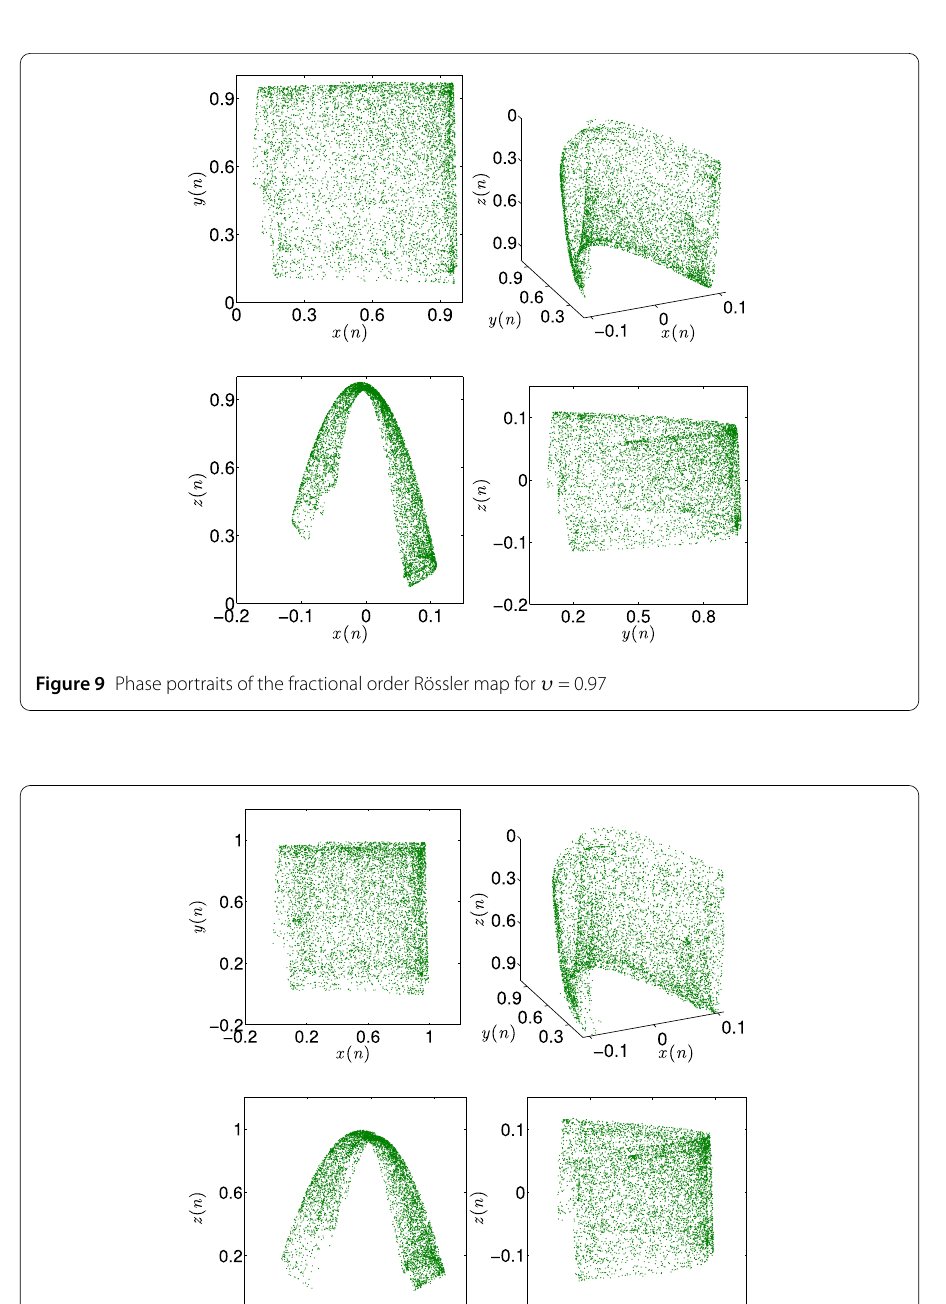
0.903. Figure 11 shows the bifurcation diagram for υ = 0.97 with b 1 as the critical pa- rameter and ( b 2 , b 3 , b 4 , b 5 , b 6 , b 7 ) = (0.05,0.35,3.78,0.2,0.1,1.9). The critical parameter was varied with the step size (cid:2) b 1 = 0.001. Figure 12 shows the bifurcation diagram of the fractional Rössler map with υ ∈ [0.9,1] as the critical parameter, ( b 2 , b 3 , b 4 , b 5 , b 6 , b 7 ) = (0.05,0.35,3.78,0.2,0.1,1.9) and ( x (0), y (0), z (0)) = (0.1,0.2,–0.5). We see that chaos is